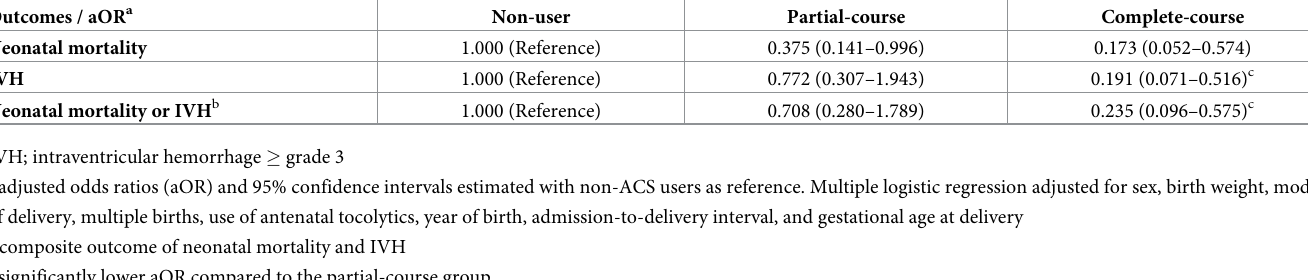
Table 5. Adjusted odds ratio and 95% confidence interval (CI) of neonatal mortality and intraventricular hemorrhage by exposure to ACS therapy. Outcomes / aOR